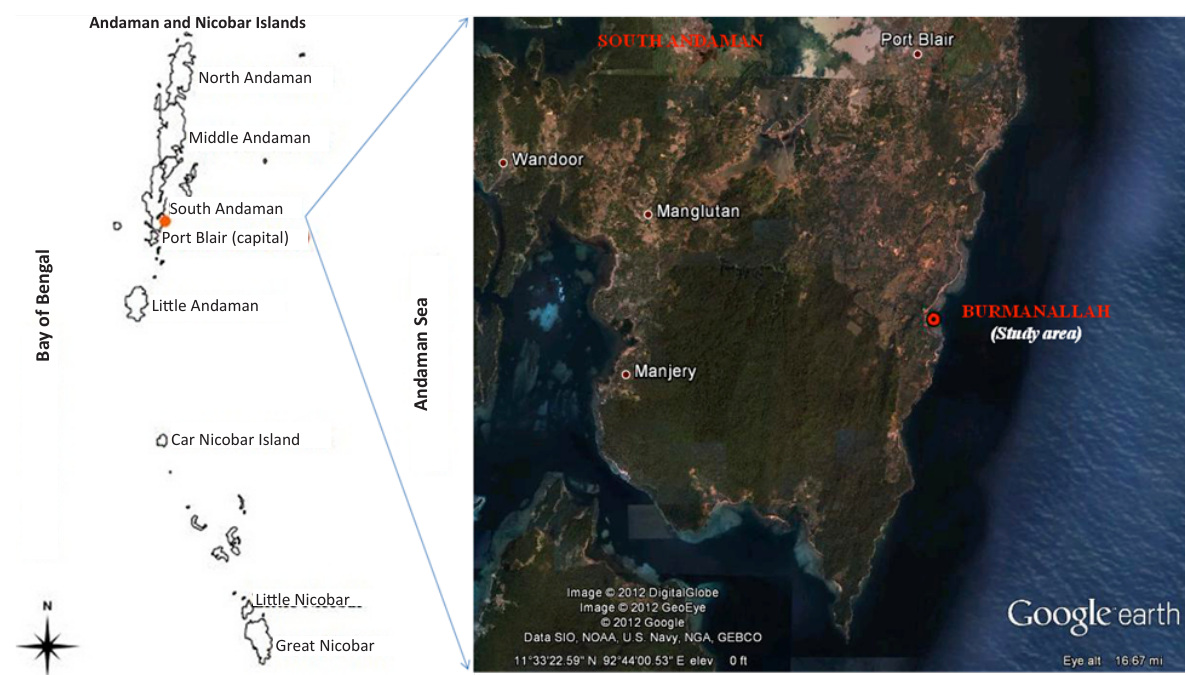
live. Color faded with traces of green marbling on the telson and uropods and with rows of small dark